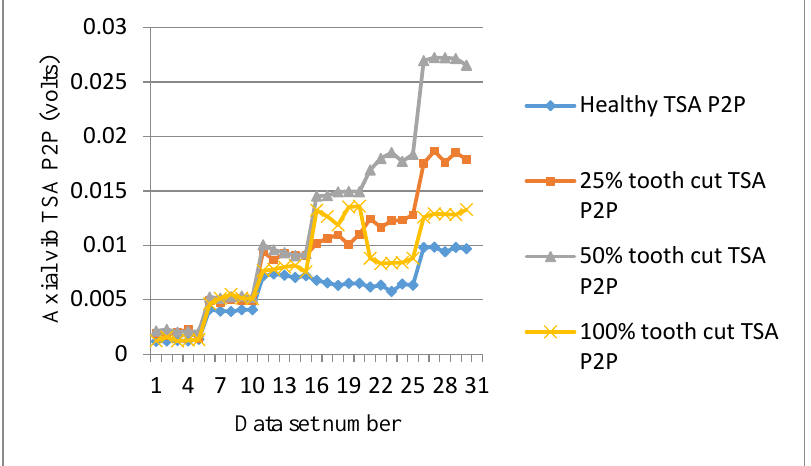
Figure 12. P2P of the axial vibration TSA signals.